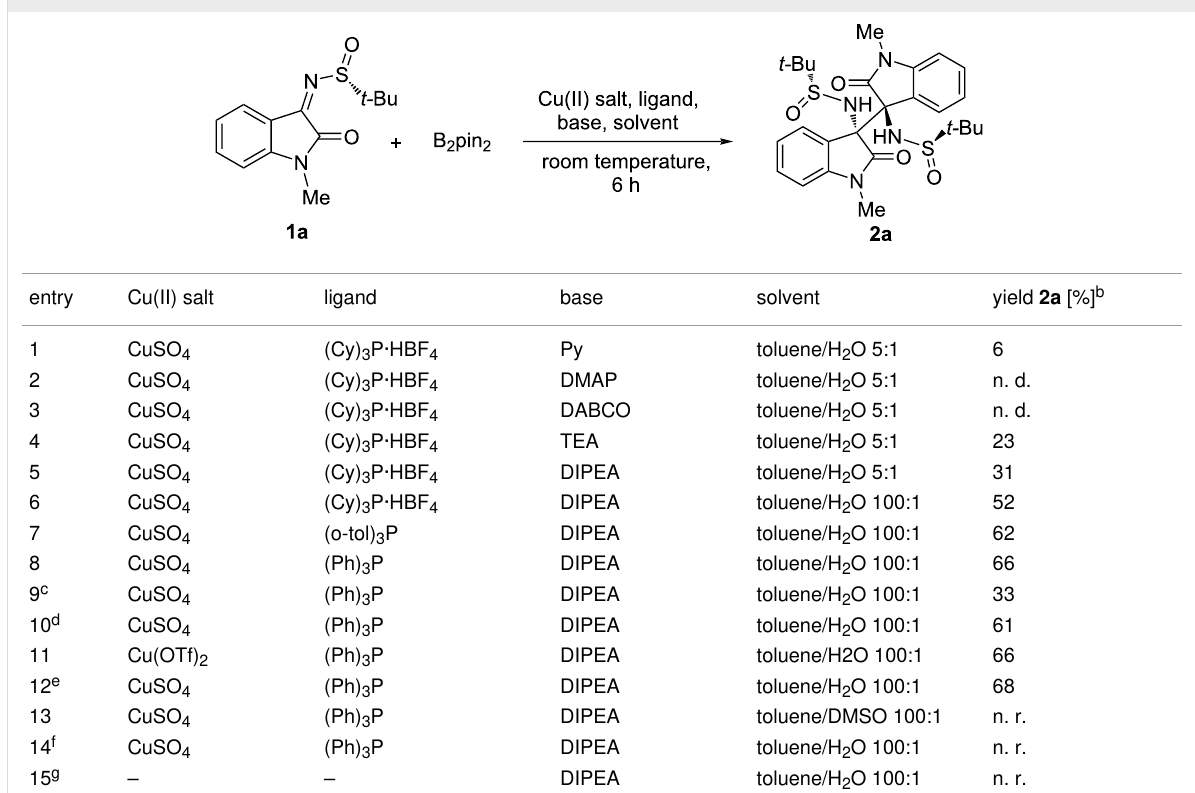
Table 1: Screening of the reaction conditions for compound 2a . a